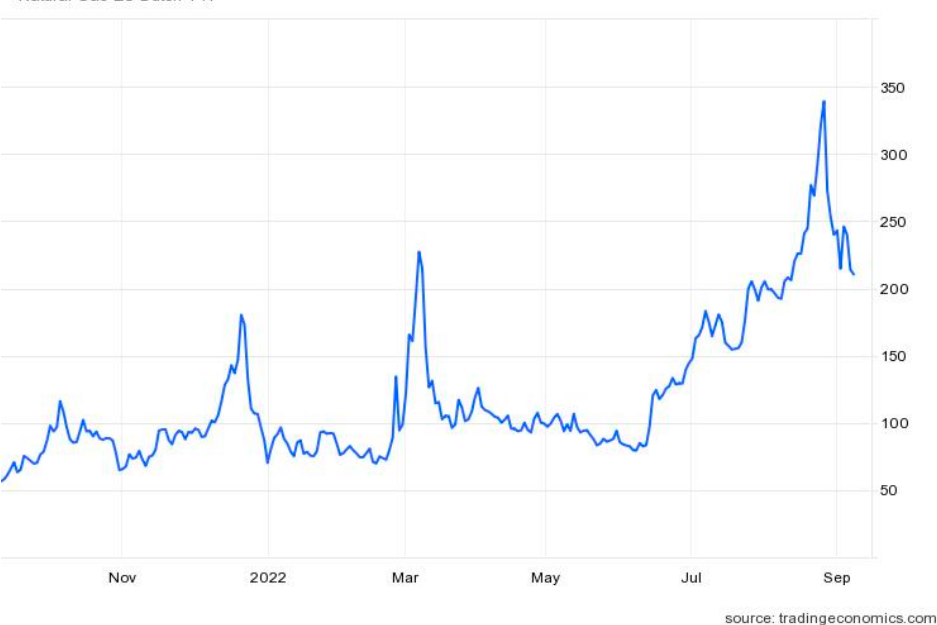
Figure 9. Dutch TTF European natural gas price dynamics in 2021–2022 (EUR/MWh). Source: [66].